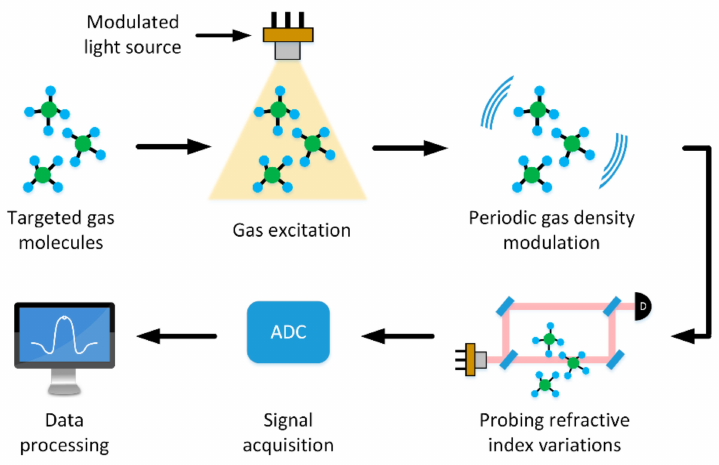
Figure 1. The principle of the photothermal spectroscopy